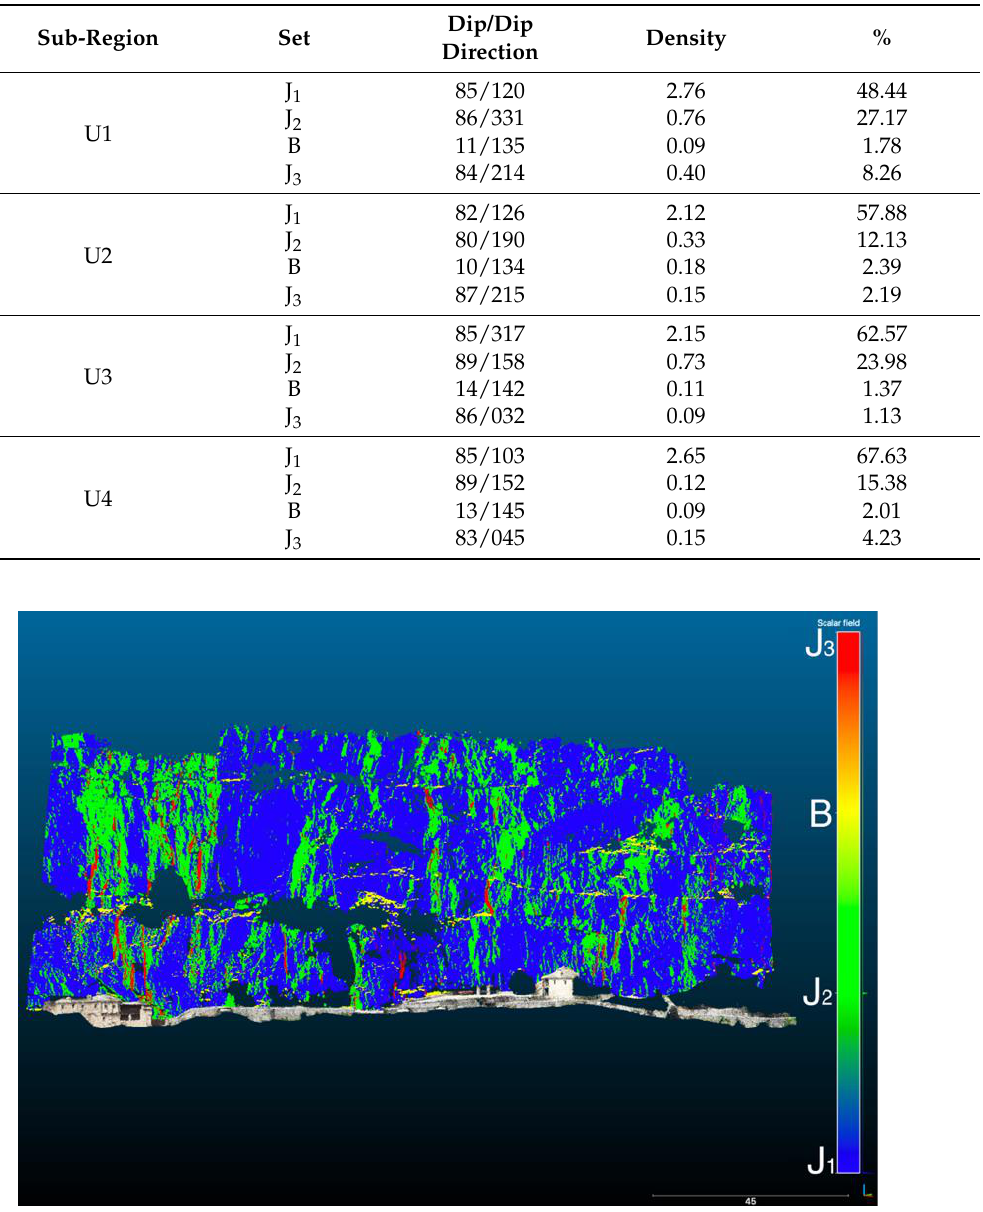
Figure 5. Overall image of the whole slope and the allocation of each main discontinuity set on it.